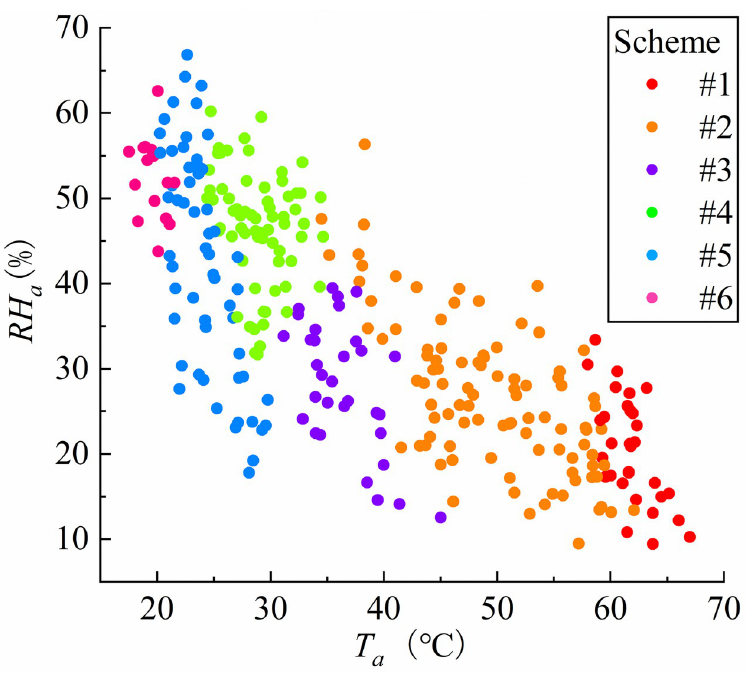
Fig 13. T ca and schemes distribution of the sample point. The 300 samples selected consider the uniformity and representativeness of the sample points in the thermal environment state.